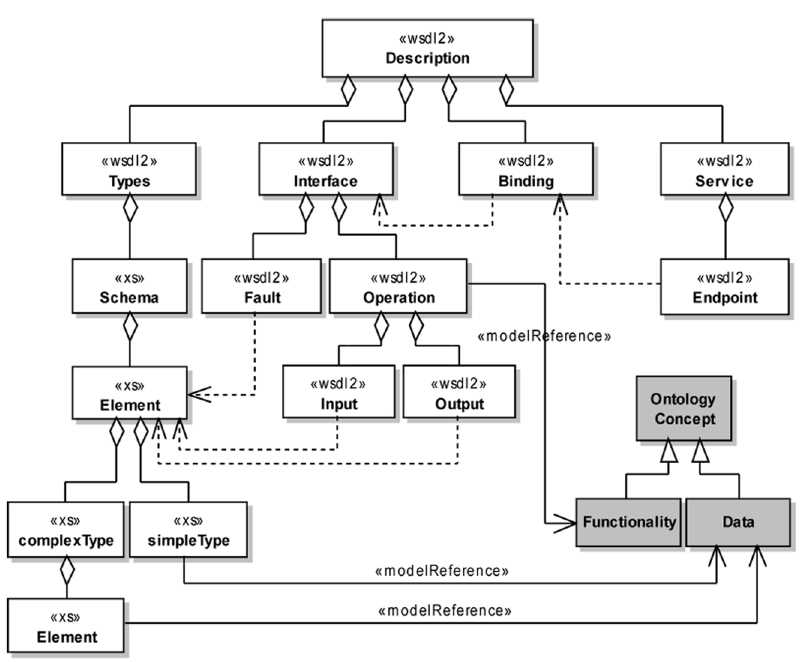
Fig 3. Annotation of WSDL elements using the modelReference attribute according to the proposed methodology. A named rectangle represents a UML class. A white class represents a WSDL element, while a gray class represents a service ontology element. A directed dashed line (UML dependency) indicates that a WSDL element references another one. A solid line with an hollow diamond (UML aggregation) is used to indicate a WSDL element contained as part of another one. A solid line with an hollow triangle as an arrowhead (UML generalization) represents a subsumption relation between ontology concepts. Finally, a directed solid line (UML association) stereotyped as < < modelReference > > represents the use of the modelReference attribute to annotate a WSDL element with an ontology concept. Each general-purpose WSDL operation is associated to an ontological concept representing a service functionality. Each simple/ complex XML Schema type definition is associated to an ontological concept representing a data format. The annotation of complex types is presented only at the member element